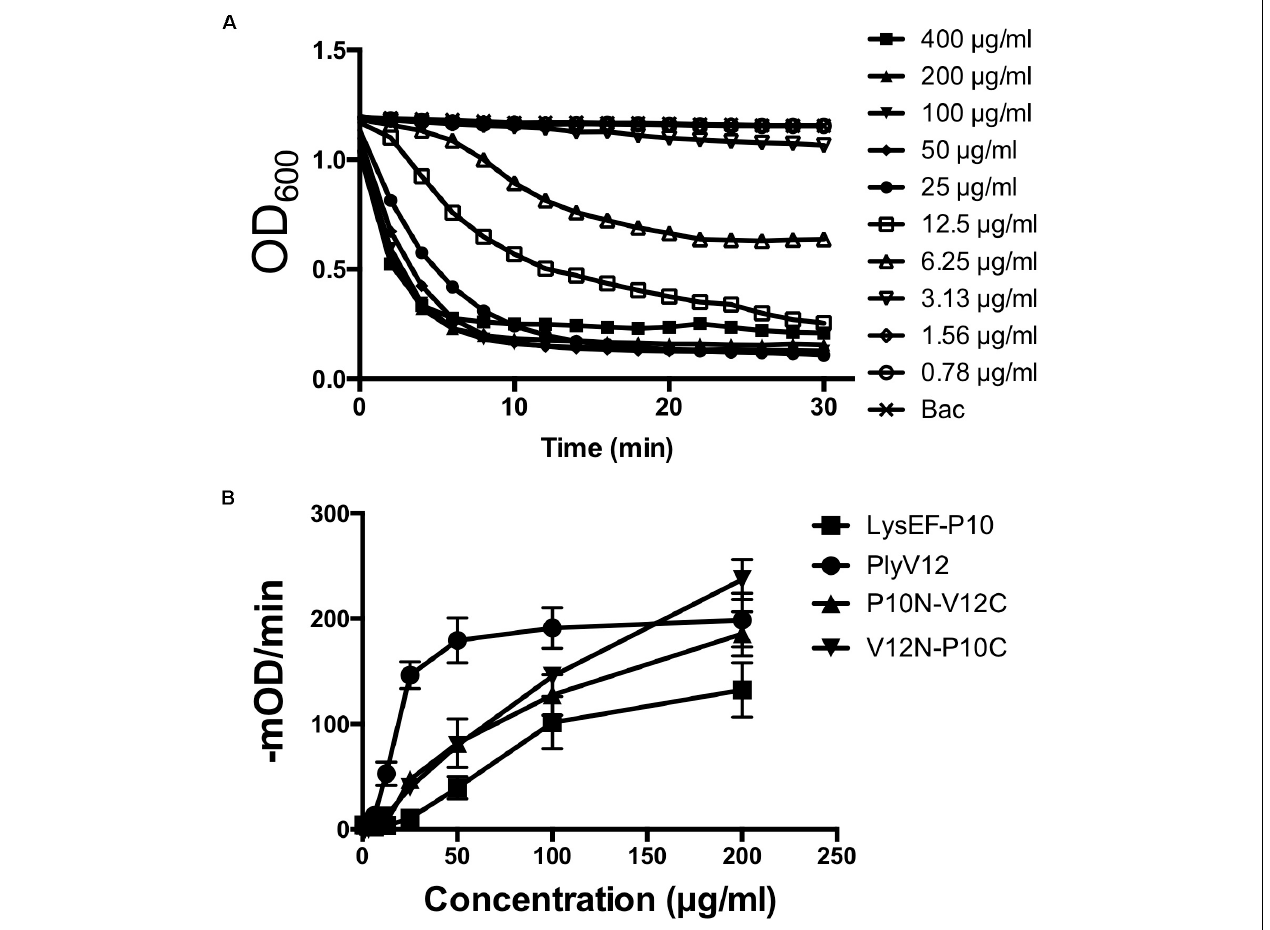
FIGURE 3 | Lytic activity characterization. (A) Lytic kinetics of PlyV12 against E. faecalis OR1GF strain at various doses as measured by the reduction in OD 600 . (B) Lytic activity at various doses as measured by the rate of reduction in OD 600 in the first 3 min. These experiments were performed in biological triplicates; error bars represent standard